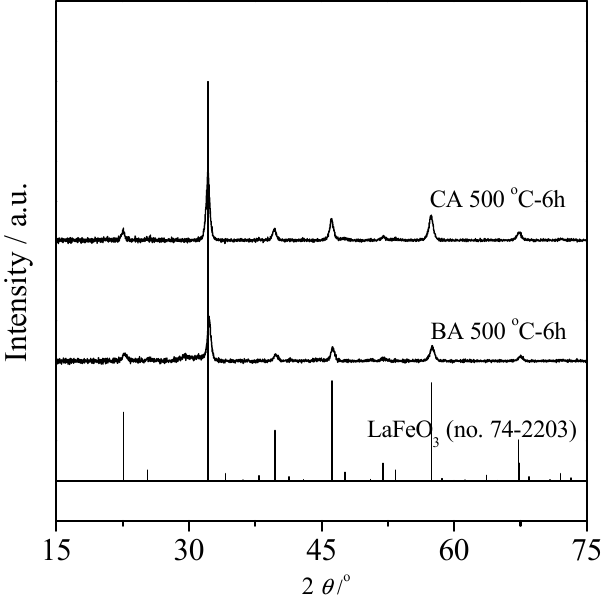
Figure 2. XRD results for LaFeO 3 samples prepared by the BA and CA routes. Bottom of the figure: vertical lines for reference LaFeO 3 (JCPDS card 74-2203).